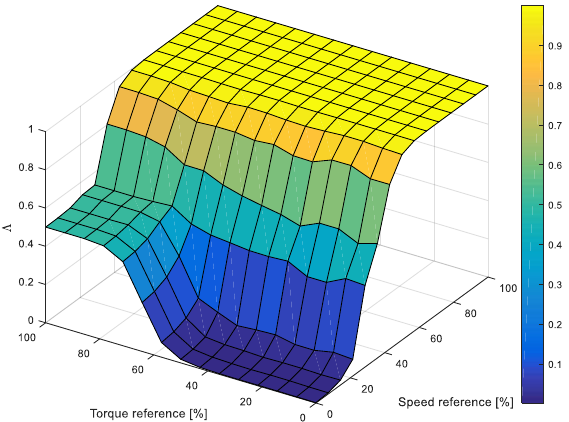
Figure 7. Output of the fuzzy logic transition block.